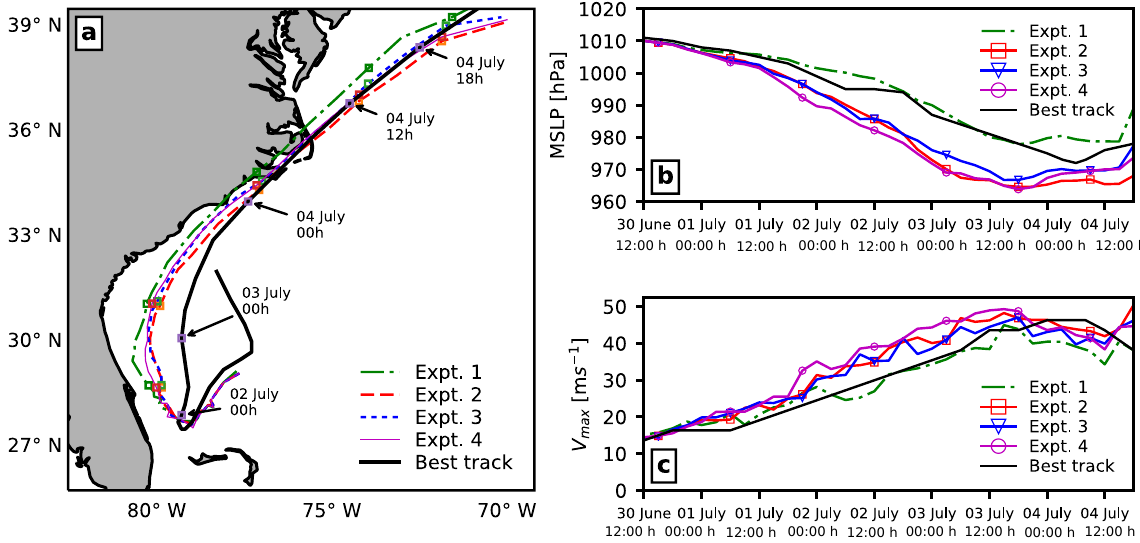
Figure 2. Comparison of (a) hurricane track, (b) time series of minimum sea level pressure (MSLP), and (c) time series of maximum wind speed ( V max ) for the best track observed and four model